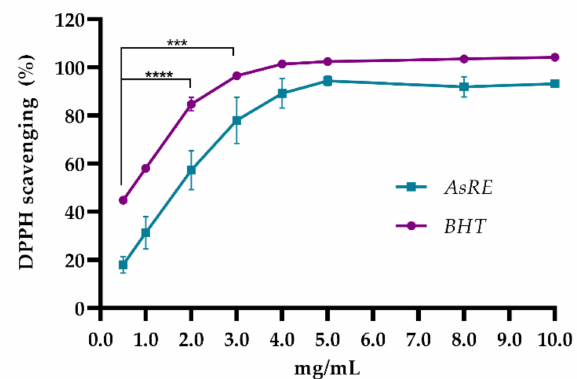
Figure 2. DPPH radical scavenging assay; AsRE = A. sisalana agro-industrial residue extract; *** p < 0.001 and **** p < 0.0001, by two-way ANOVA, by one-way ANOVA, followed by a Tukey’s post-test. The assay was carried out in three independent experiments and performed in triplicate. The results were expressed as mean ± DP.